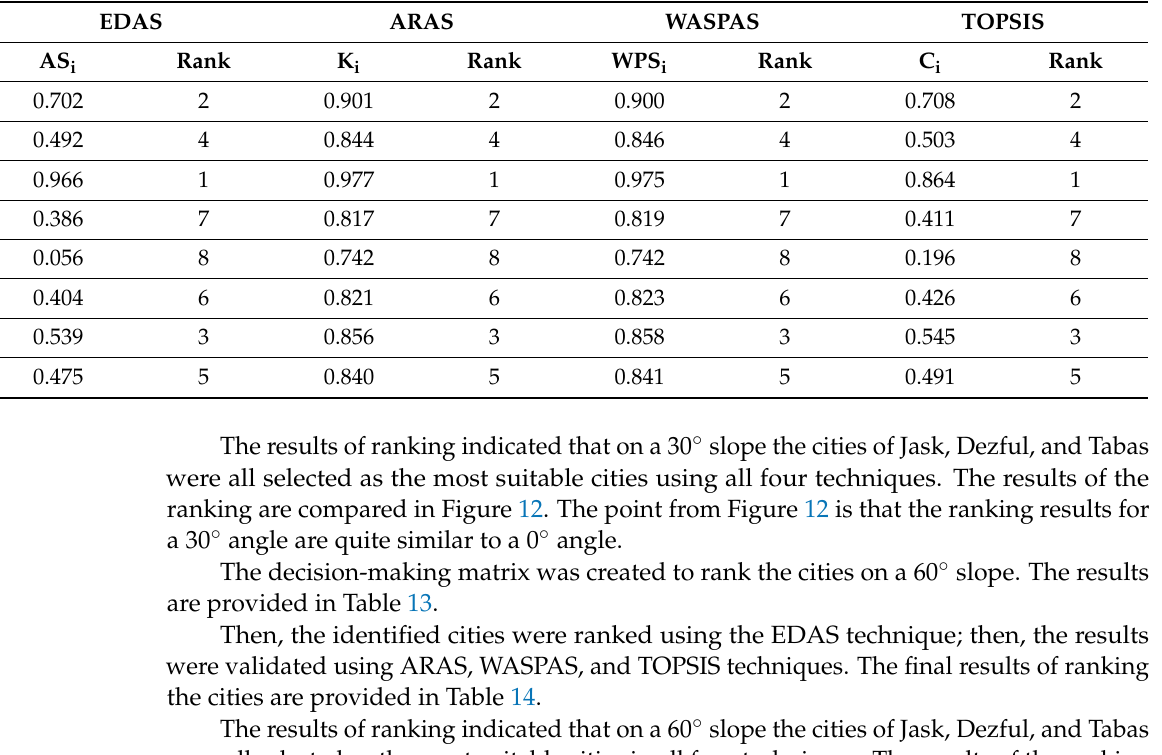
Table 12. Results of ranking of cities on a 30 ◦